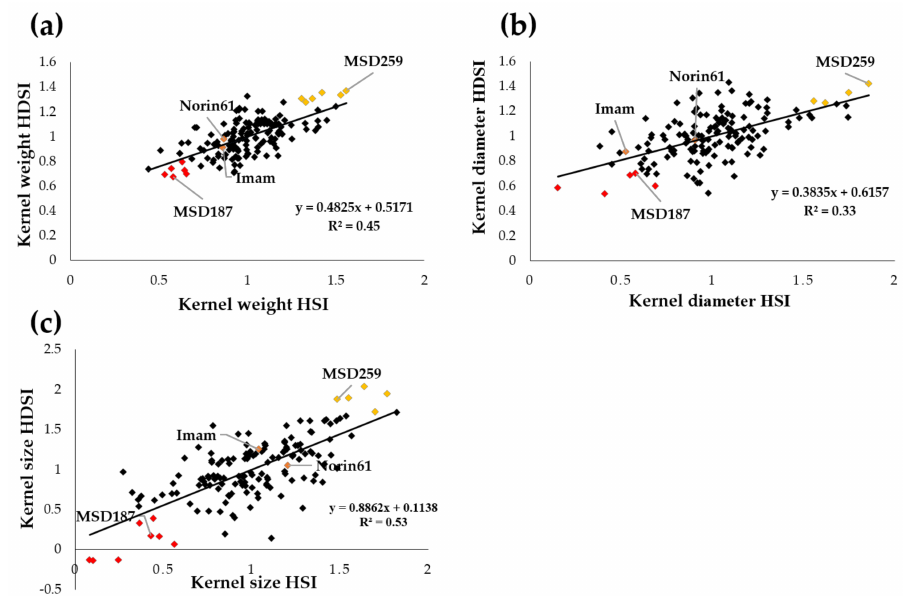
Figure 3. Regression analysis of the relationship between the heat susceptibility index (HSI) and the combined heat–drought susceptibility index (HDSI) for kernel ( a ) weight; ( b ) diameter; and ( c ) area size. Red color indicates tolerant lines with an index value of about 0.5 and yellow color indicates sensitive lines with an index value higher than one. The genetic background parent of the MSD lines Norin 61, the leading Sudanese cultivar Imam and two representative MSD lines showing high (MSD259) and low (MSD187) reductions are